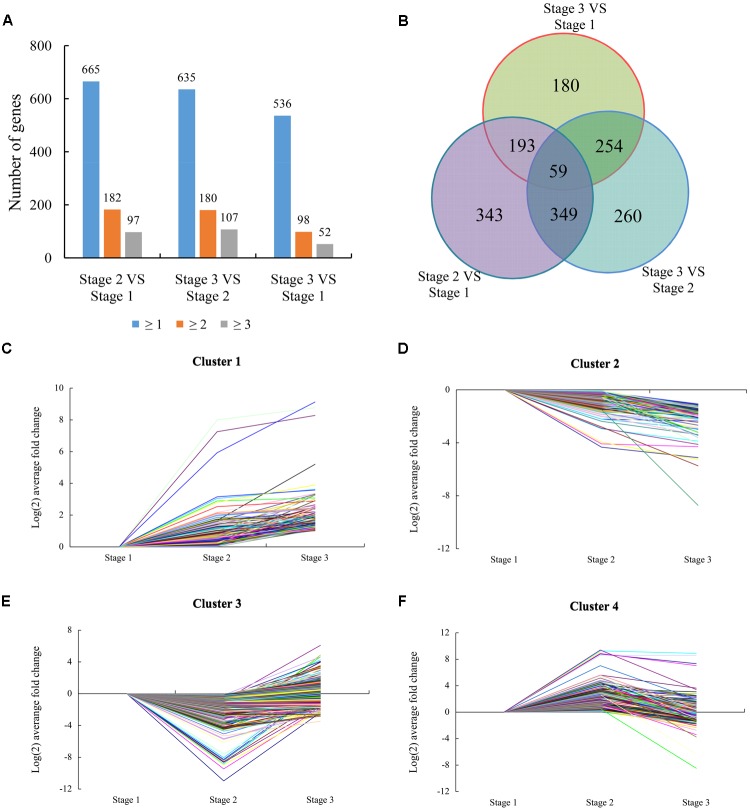
Expression patterns of differentially expressed genes (DEGs). (A) The total numbers of genes differentially expressed (including up- or down-regulated, fold changes ≥ 1, 2, and 3) at stage 2 compared with stage 1, stage 3 compared with stage 2, and stage 3 compared with stage 1, respectively. (B) Venn diagram showing the overlapping of DEGs at three different stages (Stage 2 compared with stage 1, stage 3 compared with stage 2, and stage 3 compared with stage 1). (C) Cluster 1 consisting of 172 DEGs. (D) Cluster 2 consisting of 181 DEGs. (E) Cluster 3 consisting of 776 DEGs. (F) Cluster 4 consisting of 509 DEGs.